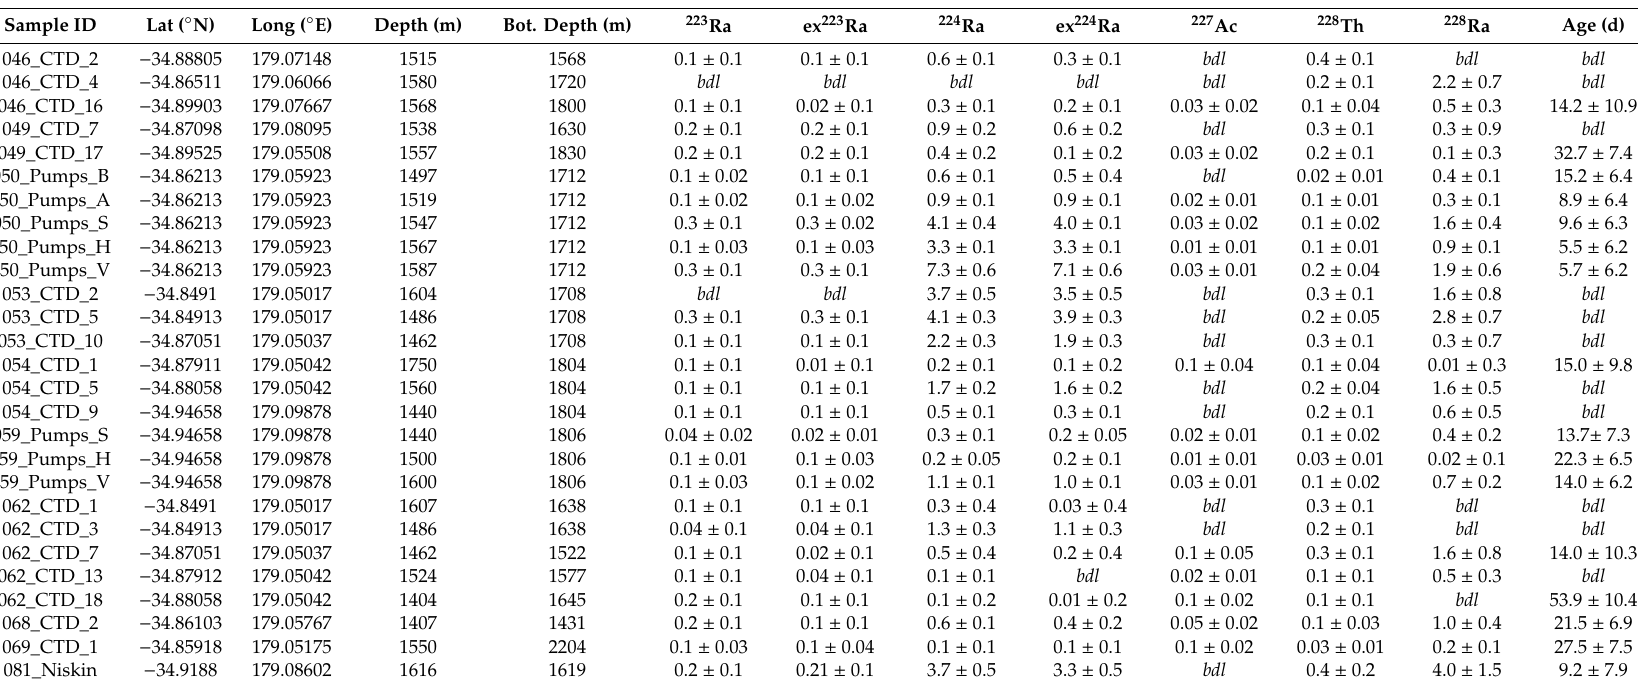
Table 1. Radium isotope activities for 223 Ra, 224 Ra, and 228 Ra of all used plume samples at Brothers volcano. Actinium (Ac) and thorium (Th) activities were used to calculate excess 223 Ra and excess 224 Ra, respectively. All activities are given in dpm / 100 L. The presented ages were calculated according to the hot hydrothermal end member ratio from Neuholz et al. [39] and represent apparent ages in days